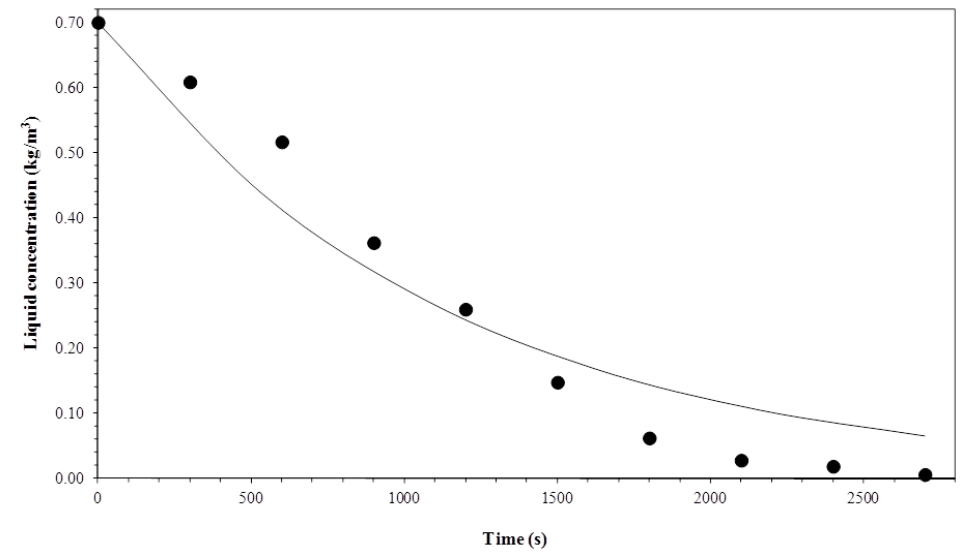
Figure 14. Comparison between experimental data and the model for a gas flow rate of 1 × 10 − 6 m 3 s − 1 and temperature of 35 °C.